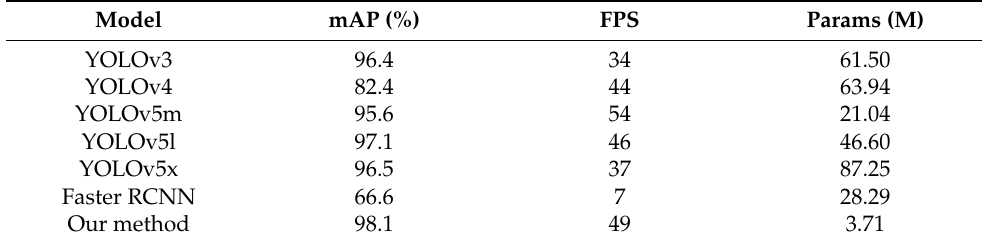
Table 3. Comparative